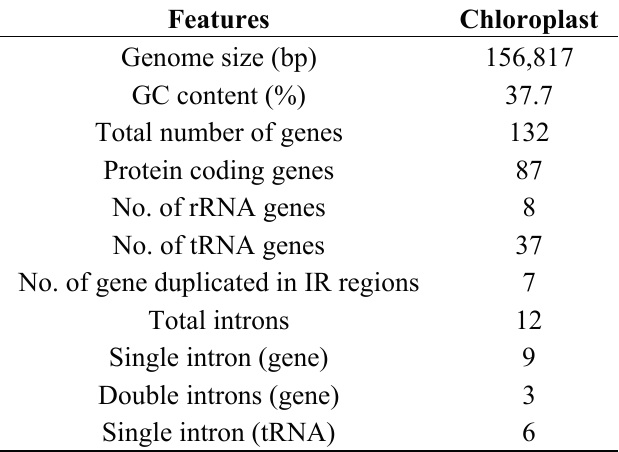
Table 1. General features of the C. annuum var. glabriusculum chloroplast